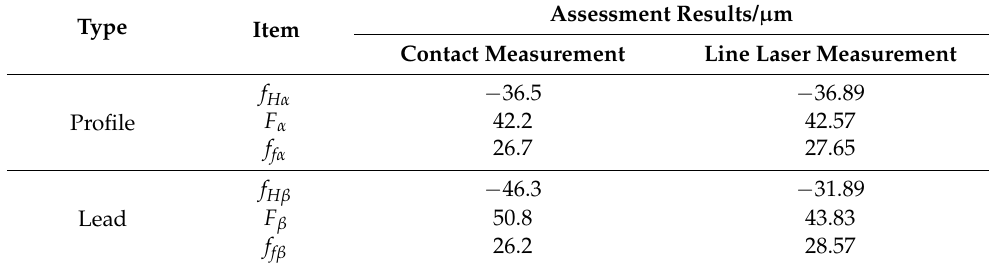
Table 2. Comparison results.